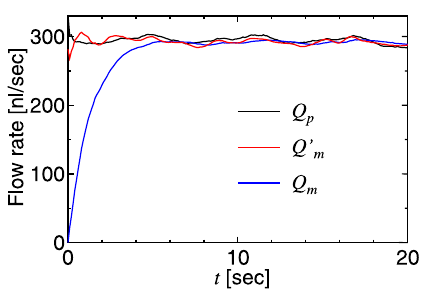
Fig. 12 Result of the compensated flow rate. Q m is given by Eq. (1) and Q (cid:4) m is compensated by Eq.